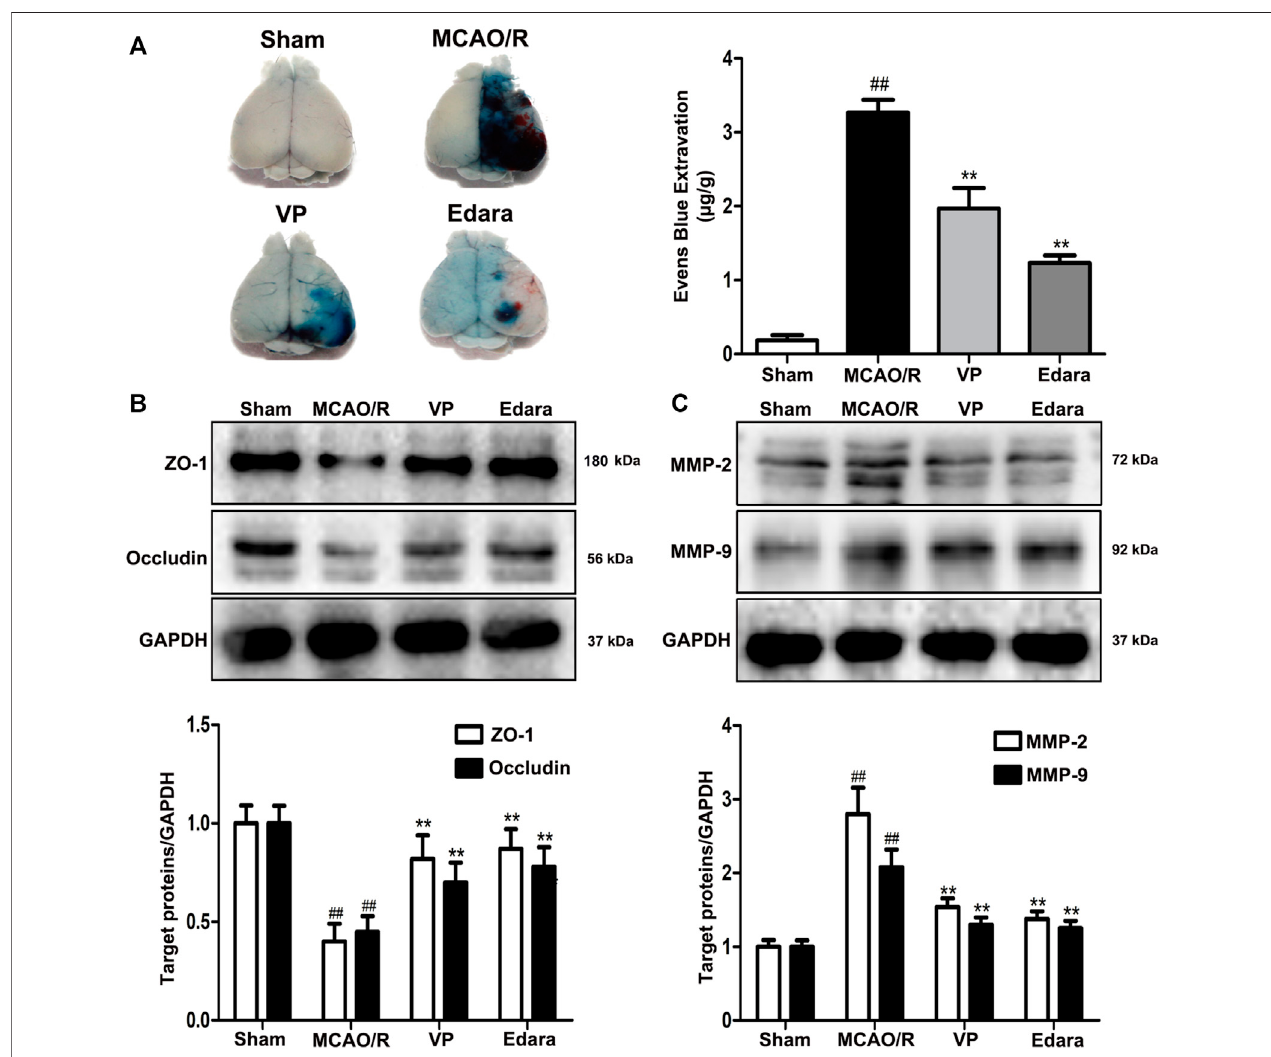
FIGURE4| EffectsofVPtreatmentonBBBdamagecausedbyMCAO/Rinjuryinmice.Miceweresubjectedto1 hofischemiaand24 hofreperfusion.Mice were treatedwithVP(10 mg/kg) after 1 hofischemia. (A) Representativegross appearance ofEB-stained brains from amousesubjectedto1 h ofischemia followed by24 h of reperfusion. (B) Representative western blots and quantitative analyses of ZO-1 and occludin expression levels after the administration of VP in mice. (C) Representativewesternblotsandquantitativeanalyses ofMMP-2/9 expressionlevelsafter theadministrationofVPinmice.Dataareexpressed asthemean ± SD, n (cid:1) 6. ## p < 0.01 vs . Sham group, ** p < 0.01 vs . MCAO/R